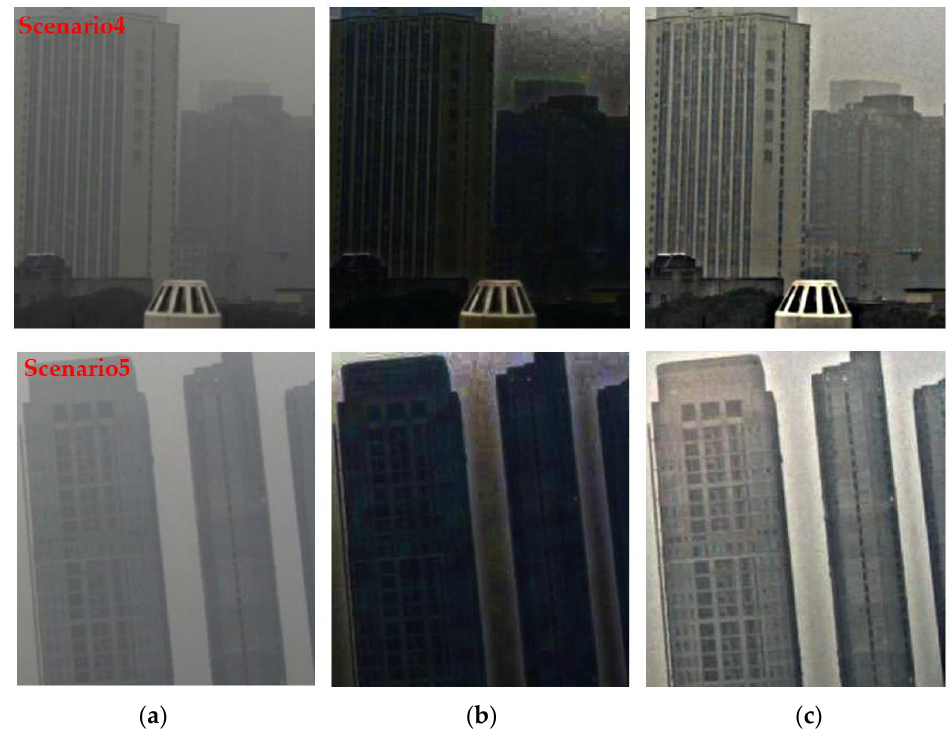
Figure 10. The comparison of deferent methods, ( a ) the original hazy image, ( b ) the result of DTMS, ( c ) the result of proposed method.